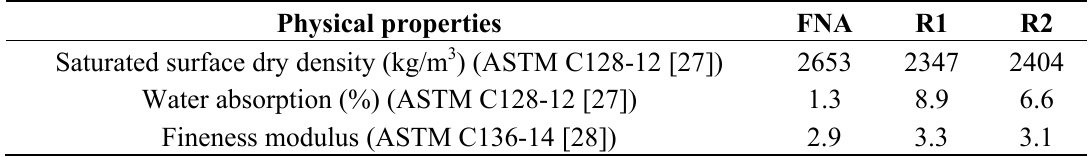
Table 1. Physical properties of FNA, R1 and R2.